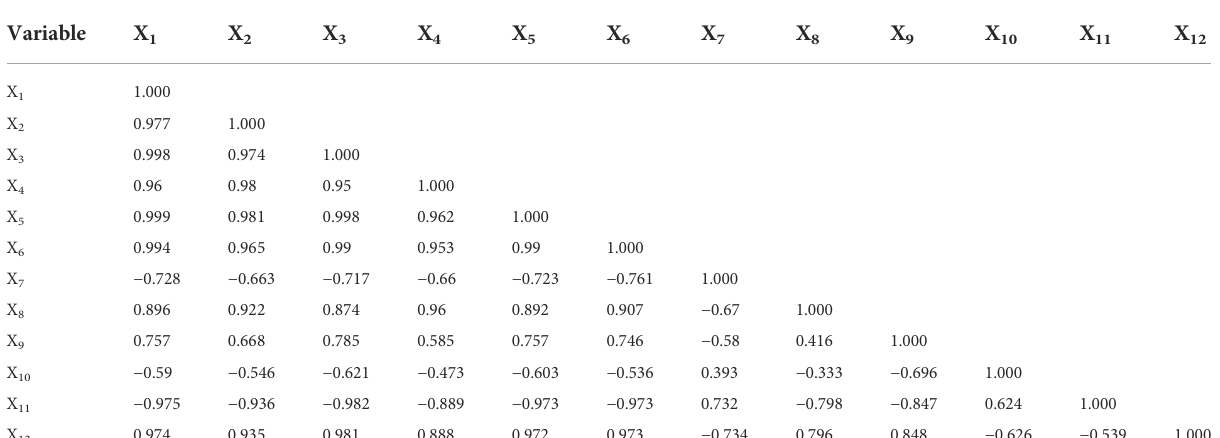
TABLE 3 Correlation matrix.